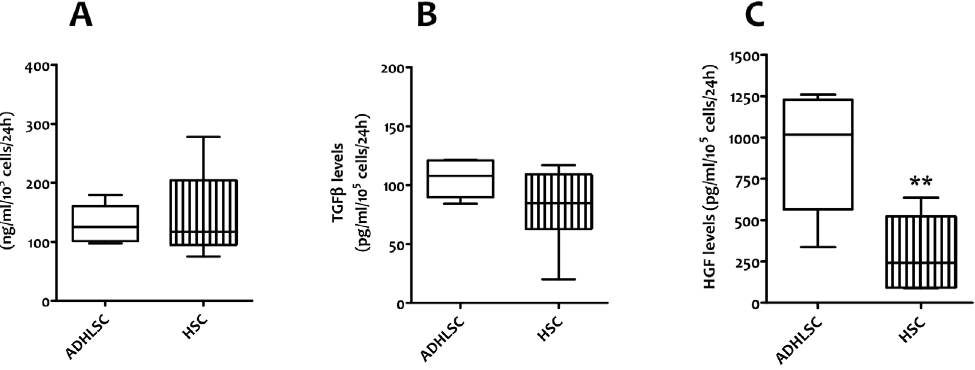
Figure 4. Secretome profile in the conditioned culture medium of ADHLSC and HSC. The Elisa analyses were performed on supernatants (n=3 including the diseased donor, analyzed at passage 5 and passage 7) collected 24 hours after incubation with serum free medium. A , the collagen secretion was evaluated by measuring the procollagen type-I C-Peptide, precursor of the collagen type I, by Elisa. No significant difference was observed between HSC and ADHLSC. B , TGF b 1 secretion; ADHLSC and HSC secrete an equivalent amount of TGF b 1 in the culture supernatant. C , HGF secretion; we observed a significant difference in HGF secretion between HSC and ADHLSC. The liver stem/progenitor cells seem to secrete HGF about three times more than